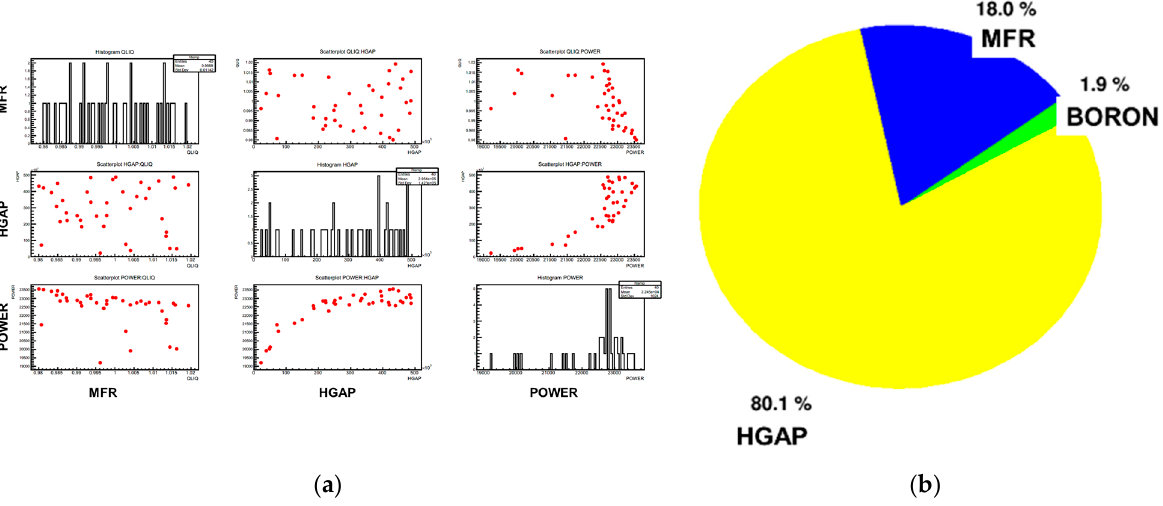
Figure 31. The 19 Hexagonal FA CORE CASE: ( a ) pairs plot (BORON, MFR, HGAP); ( b ) total sensitivity index for maximum power.